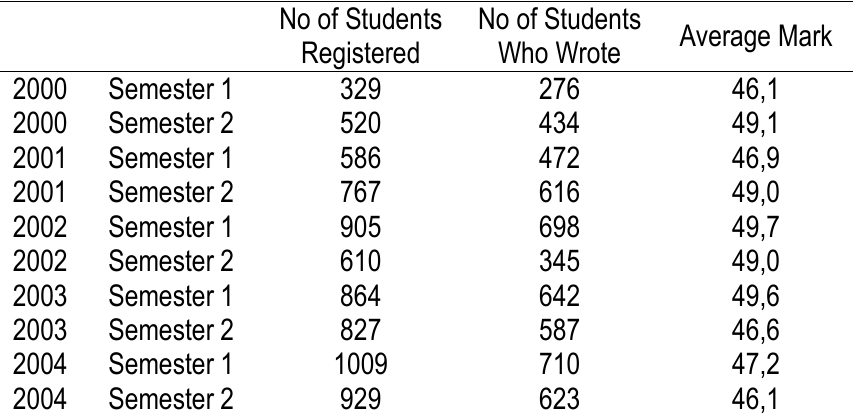
Table 1.2 indicates the final examination marks from 2000 to 2004 obtained for